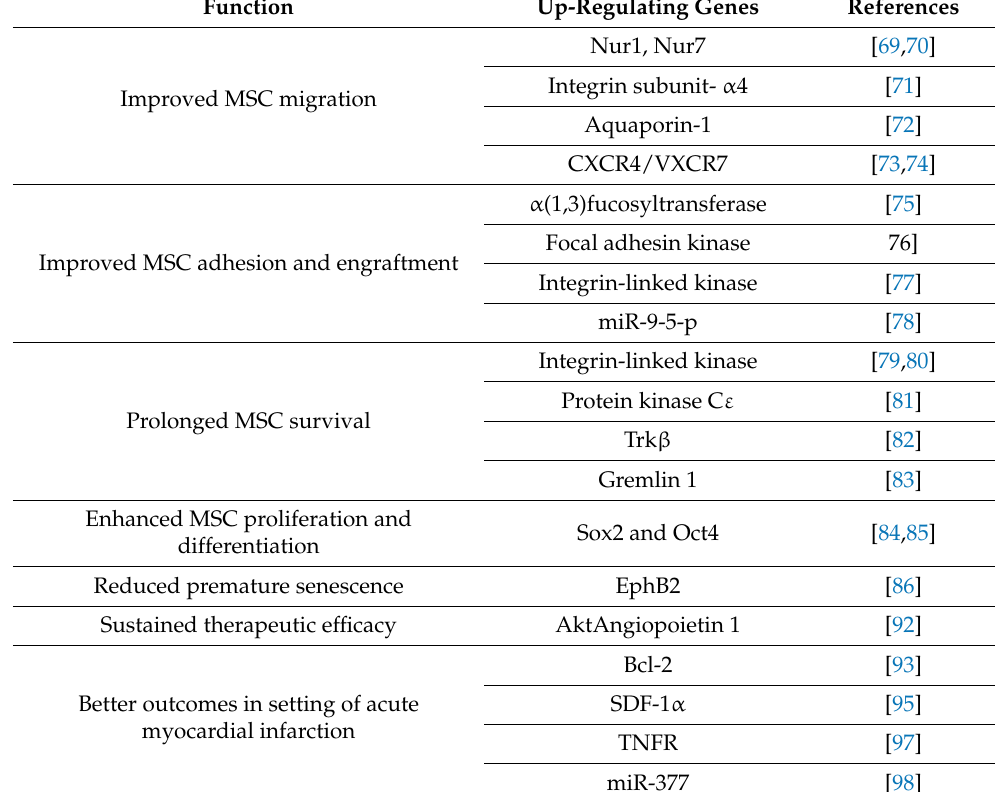
Table 2. Outcomes of genetic modifications of